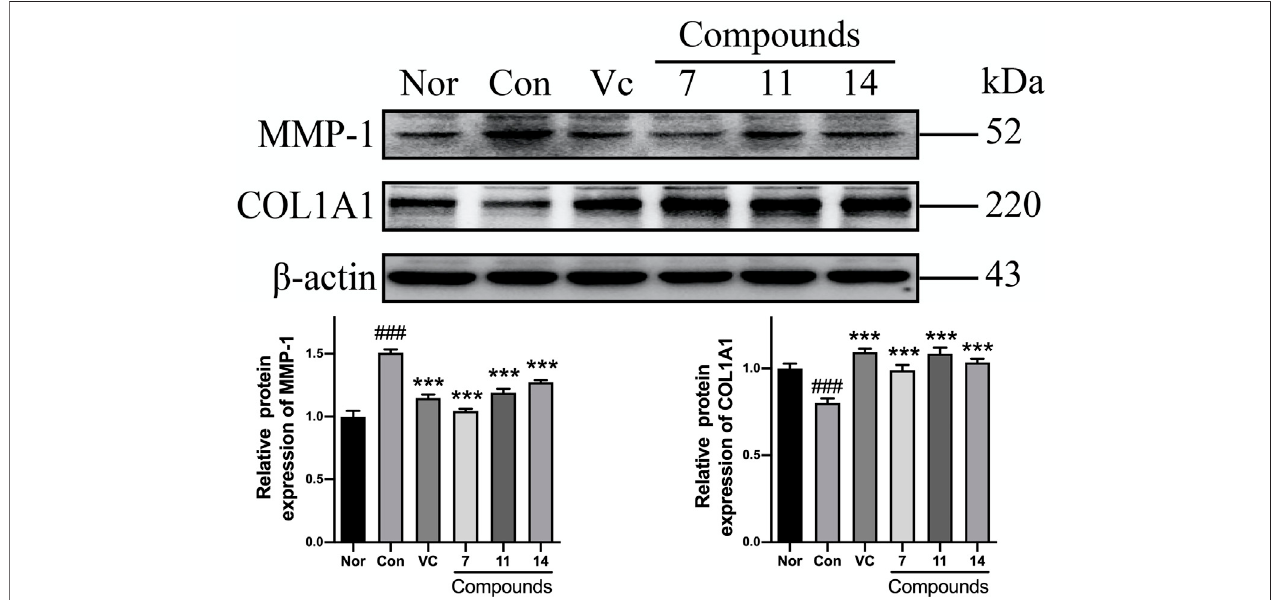
FIGURE 9 | The in fl uence of compounds 7 , 11 , and 14 at concentration of 50 μ M on the protein of MMP-1 and COL1A1 in HaCaT cells. Nor: normal group; Con: UVB-induced group; Vitamin C (Vc). Values represent the mean ± SEM of three determinations ( ### p < 0.001 vs. Nor; *** p < 0.001 vs. Con).